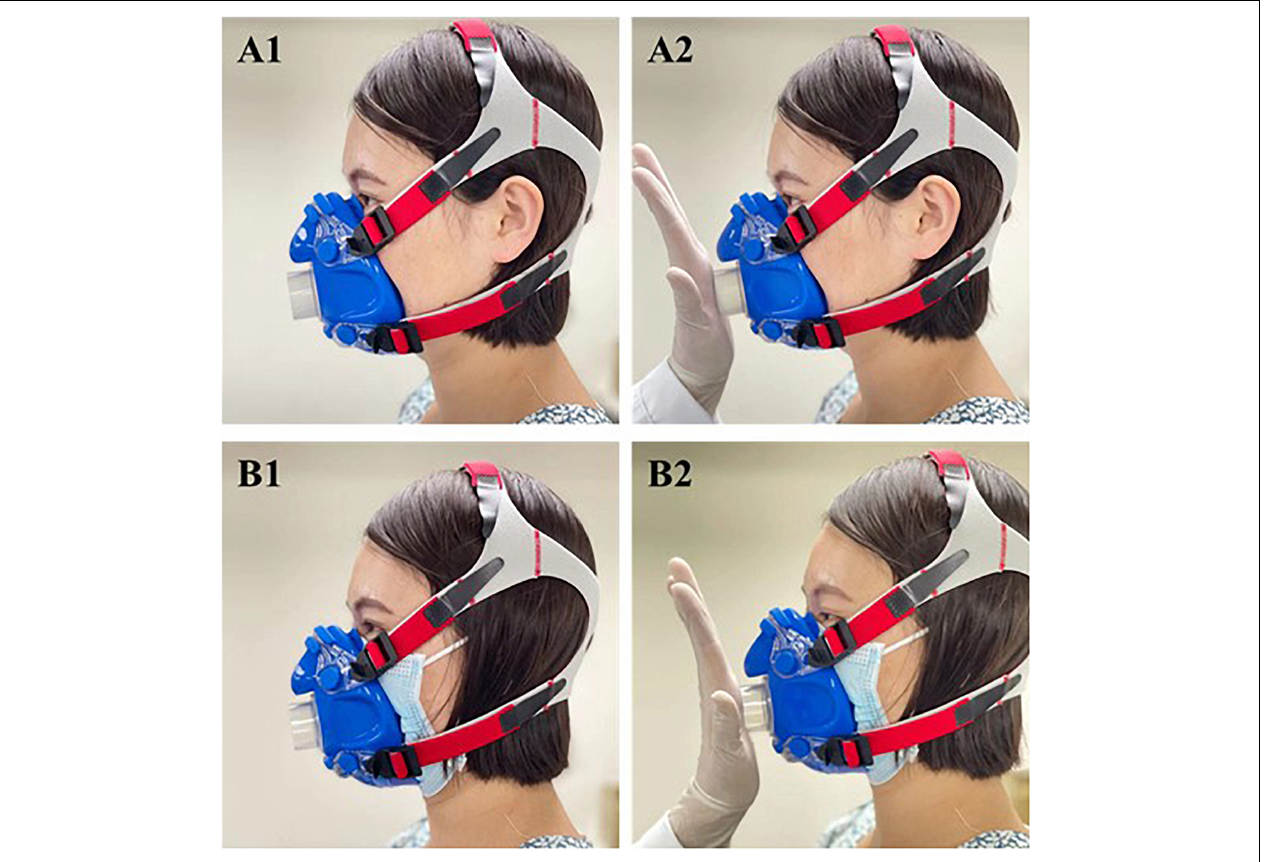
FIGURE 2 | Fit comparison of mask-on and mask-off condition. (A1) Mask-off condition. (A2) Fit test in mask-off condition. (B1) Mask-on condition. (B2) Fit test in mask-on